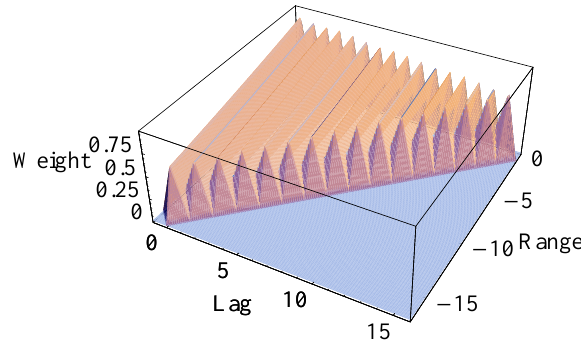
Fig. 1. Ambiguity functions W ts 1 ,ts 2 (τ,r) for a long-pulse experi- ment with a pulse 16 times the width of the sampling interval. Six- teen different ambiguity functions are actually plotted here, repre- senting sixteen different temporal lags. A small droop in transmitter power was assumed in calculating this figure.